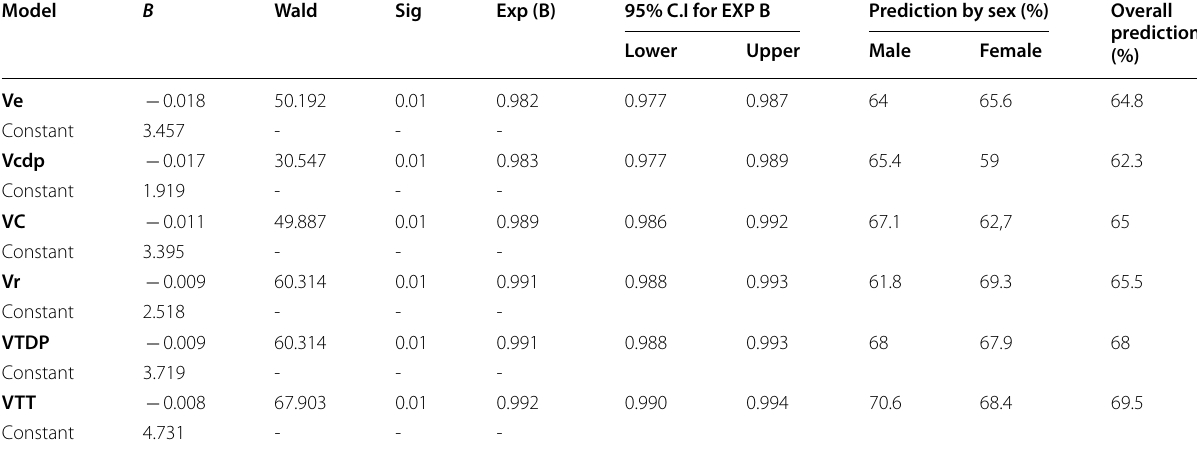
Table 4 Variable and constants used in the equations for sex prediction and their overall accuracy for the combination of teeth 23 and